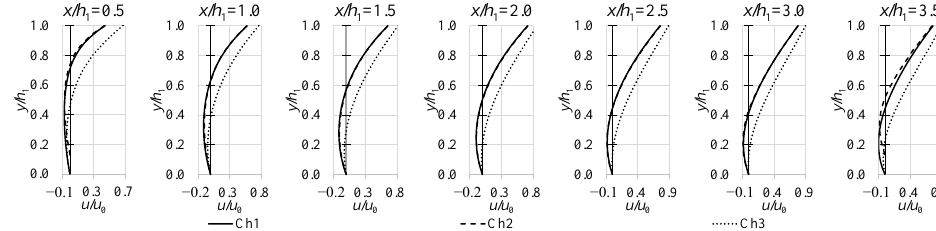
Figure 8. Velocity u profiles in Ch1, Ch2 and Ch3 at Re = 100.